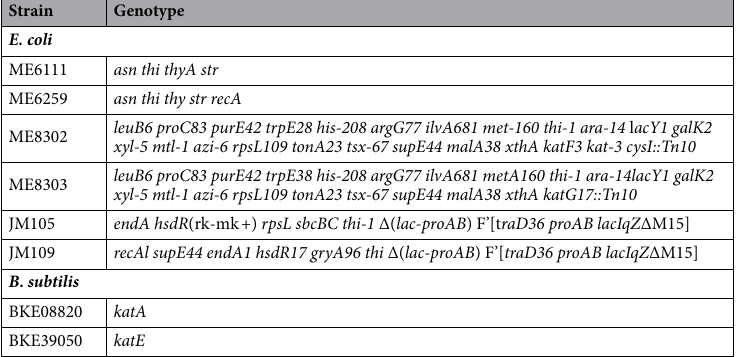
Table 2. Genotype of E. coli and B. subtilis mutants used in this study.